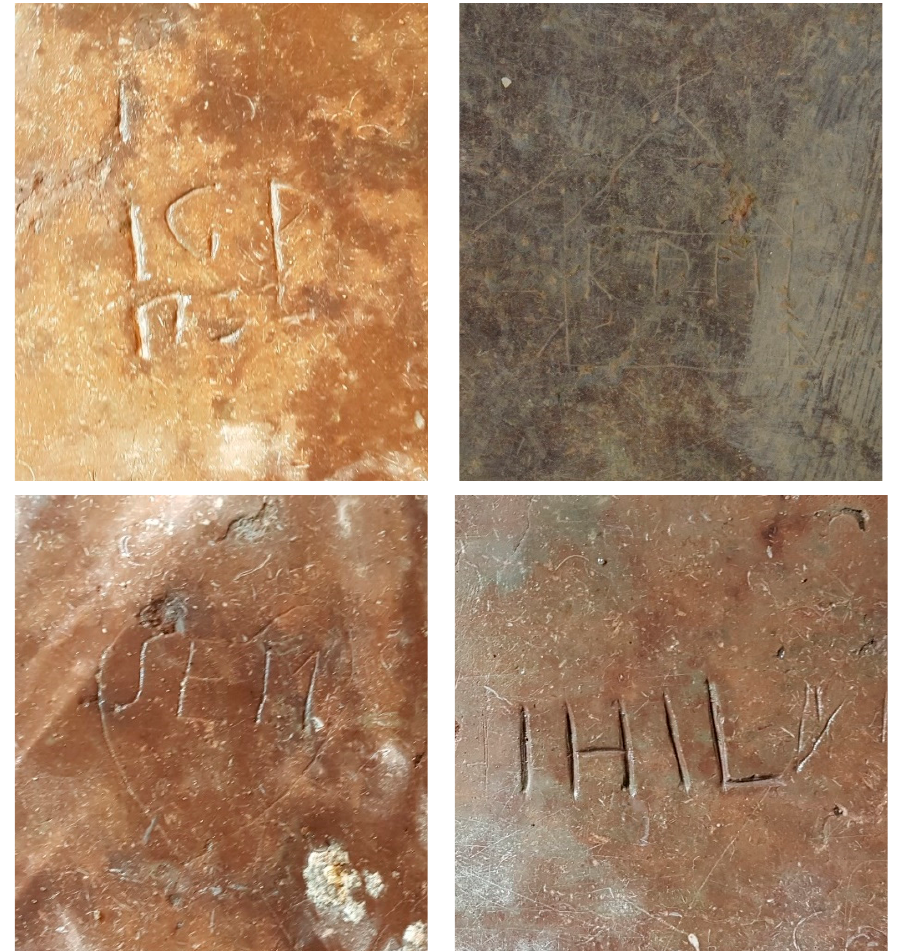
Figure 13. The graffities carved into the inscription slab after the destruction of the Great